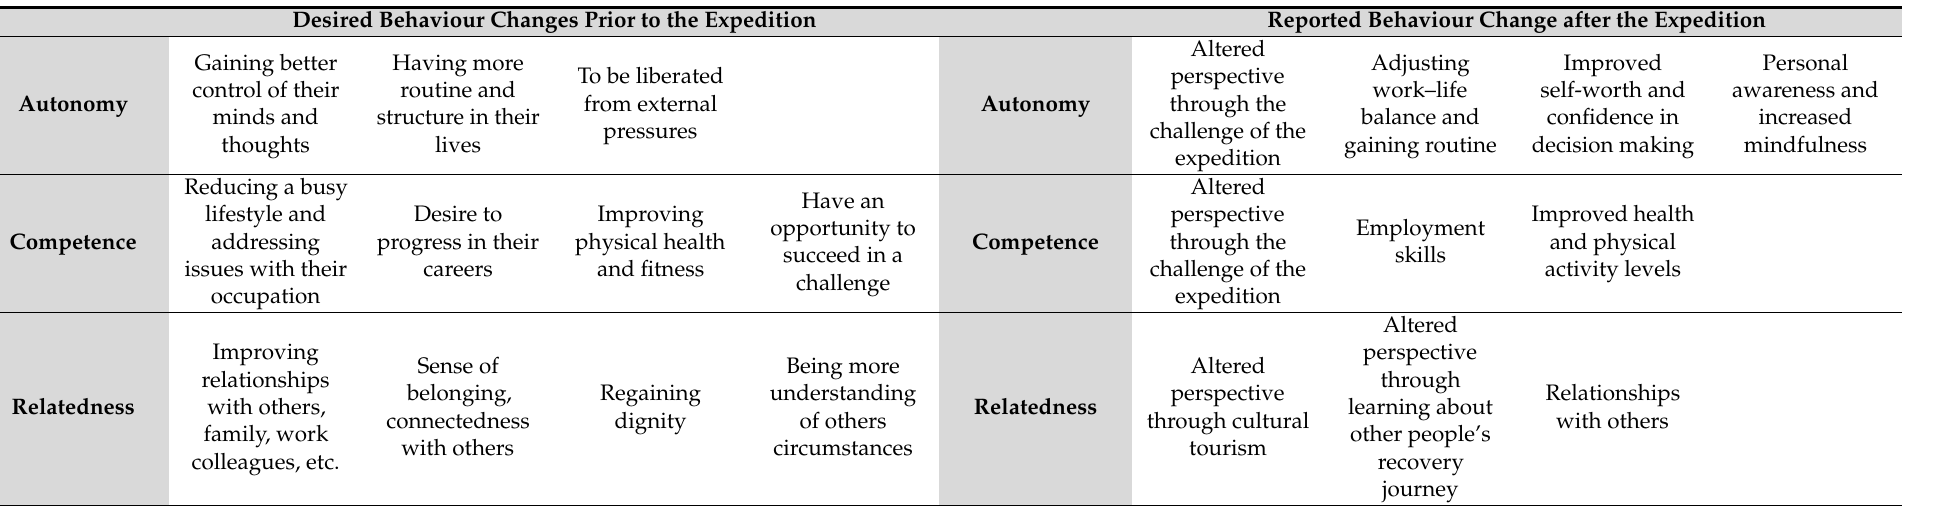
Table 1. Alignment of the desired life changes prior to the expedition and subsequent reported changes by the participants with the three basic psychological needs from